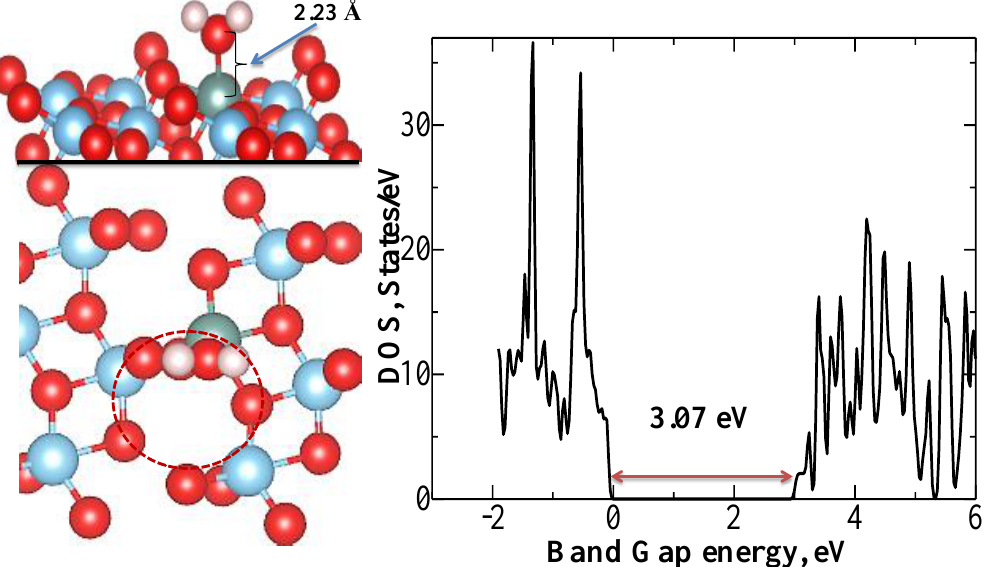
Figure 6. Structural images of the top layer and DOS of the TiO 2 :Y system upon adsorption of H 2 O – molecules parallel to the Y